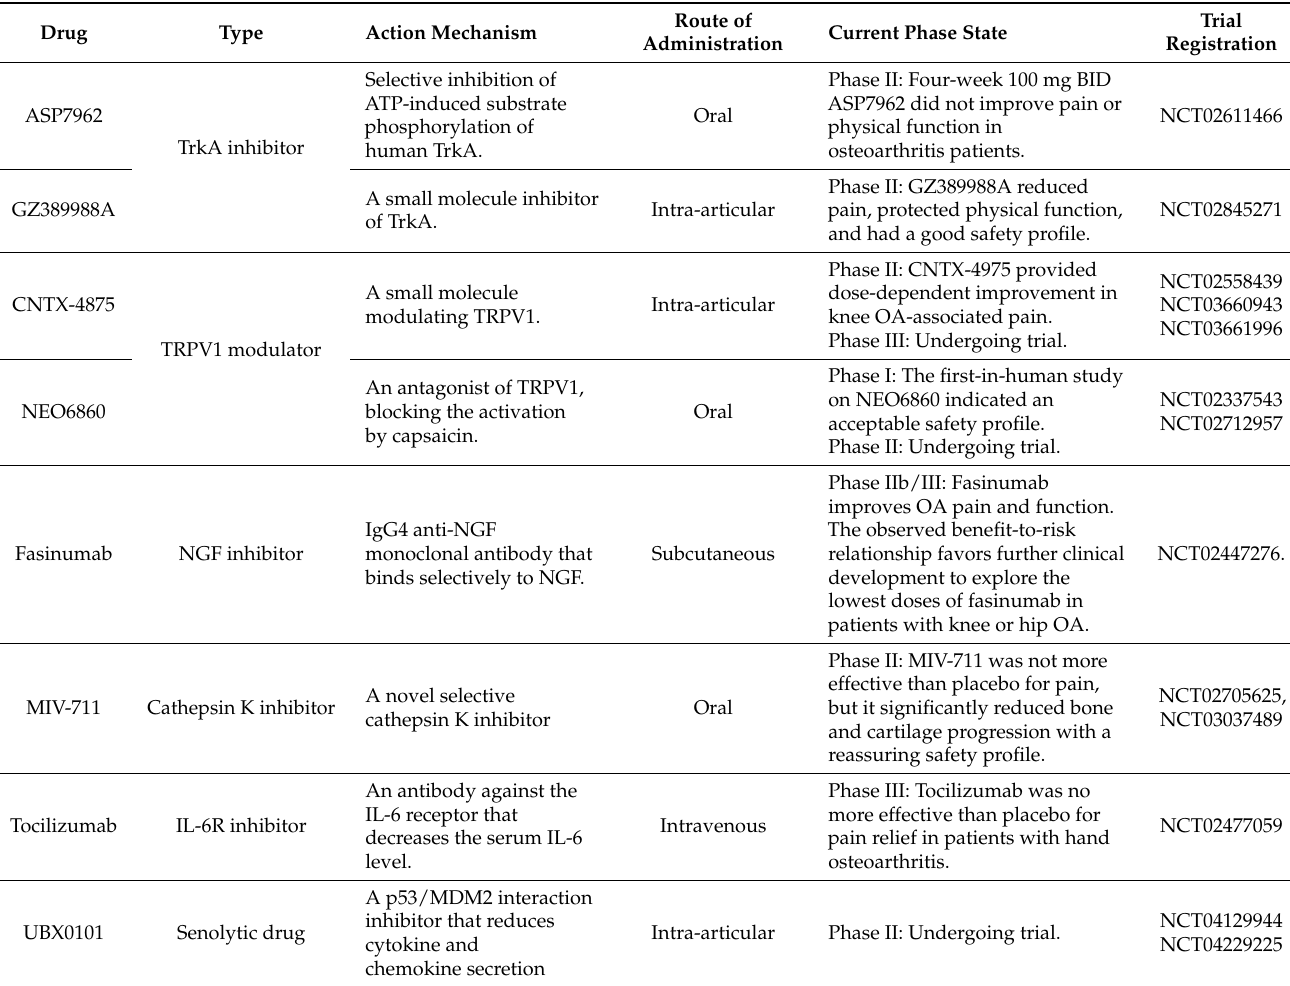
Table 7. Main potential small molecule inhibitors in OA clinical